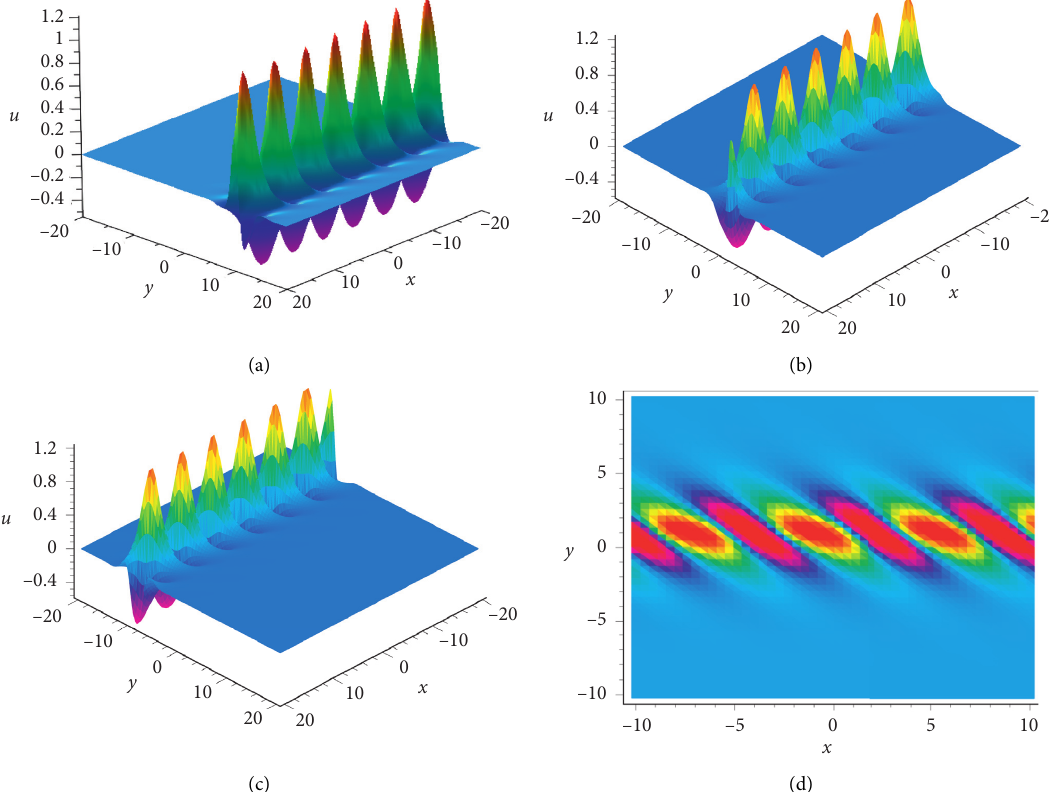
Figure 1: Evolution graphs of the first-order breather solution: (a), (b), and (c) three-dimensional plot at t � − 20, t � 0, and t � 20 and (d) density plot ( t �